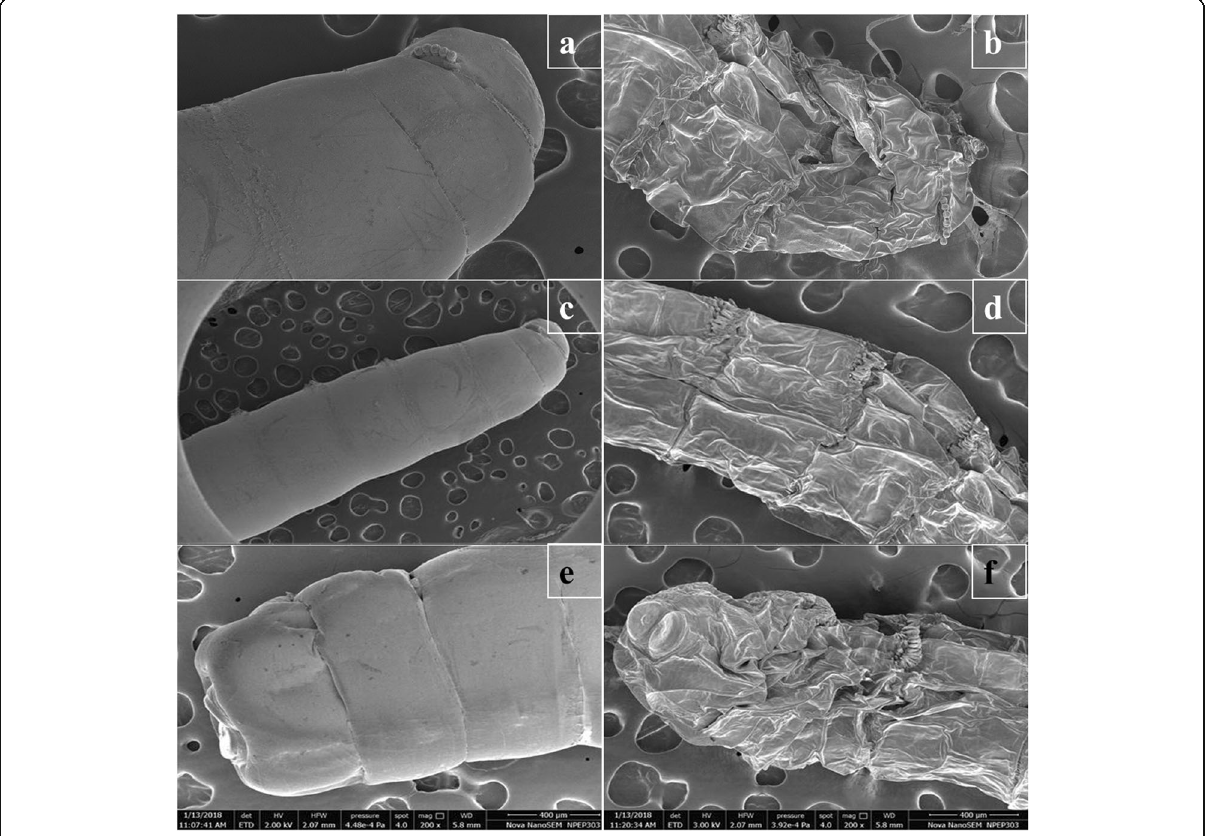
Fig. 5 The ultra-structural and superficial changes induced by bay EO to the larvae of M. domestica after a treatment for 24 h. a , c , and e show the anterior, posterior, and abdominal segments respectively of the control larva exhibiting normal appearance with smooth integument and well-defined or swollen intersegment spines, whereas b , d , and f show the FESEM micrograph anterior, posterior, and abdominal segments depicting the ultra-structural changes like shrinkage, rupture of body fluids, and corrugation of the integument induced by bay EO during